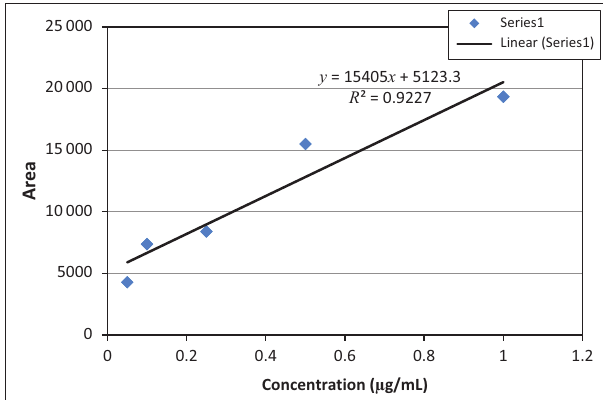
y = 15405 x + 5123.3 R ² = 0.9227